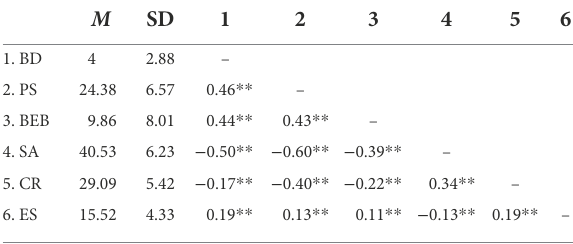
TABLE 1 Descriptive statistics and